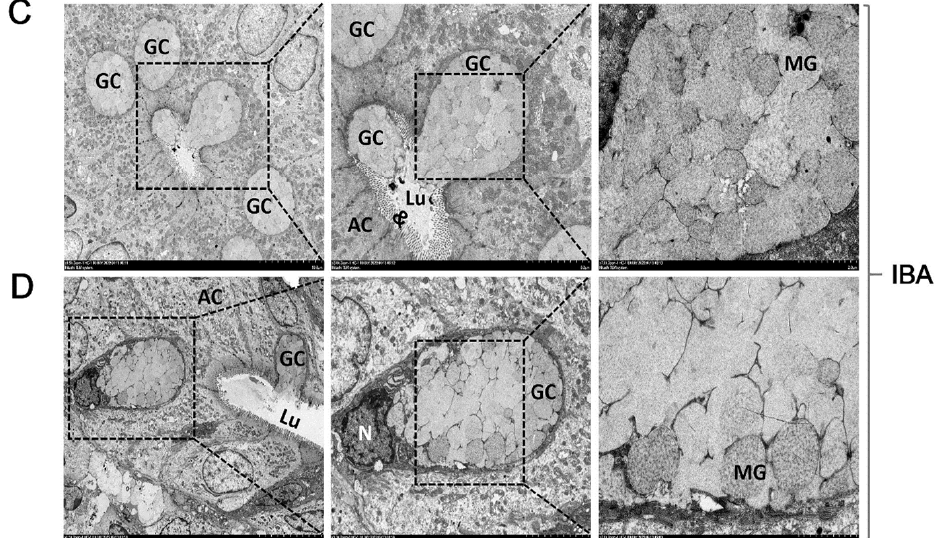
Figure 4. Transmission electron microscopy imaging of goblet cells in the colonic mucosa of the LT group ( A , B ) and the IBA group ( C , D ) of Daurian ground squirrels. Colonic lumen (Lu), goblet cells (GC), mucus granules (MG), microsomes (&), absorptive cells (AC), mitochondria (M), nucleus (N). LT, late torpor; IBA, interbout arousal.